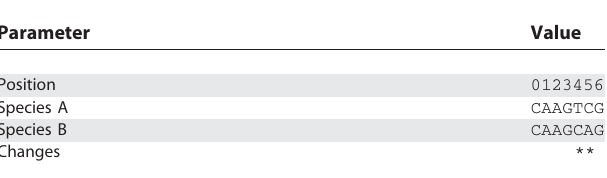
Table 4. Amplification and Sequencing Primers Primer